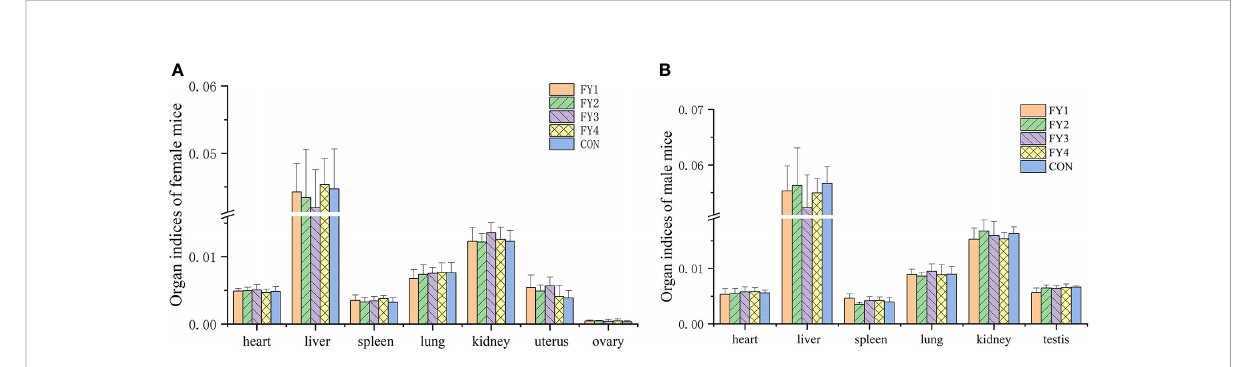
FIGURE 5 Organ indices of mice in each experimental group. (A) Organ indices of female mice (heart, liver, spleen, lung, kidney, uterus and ovary) (B) Organ indices of male mice (heart, liver, spleen, lung, kidney and